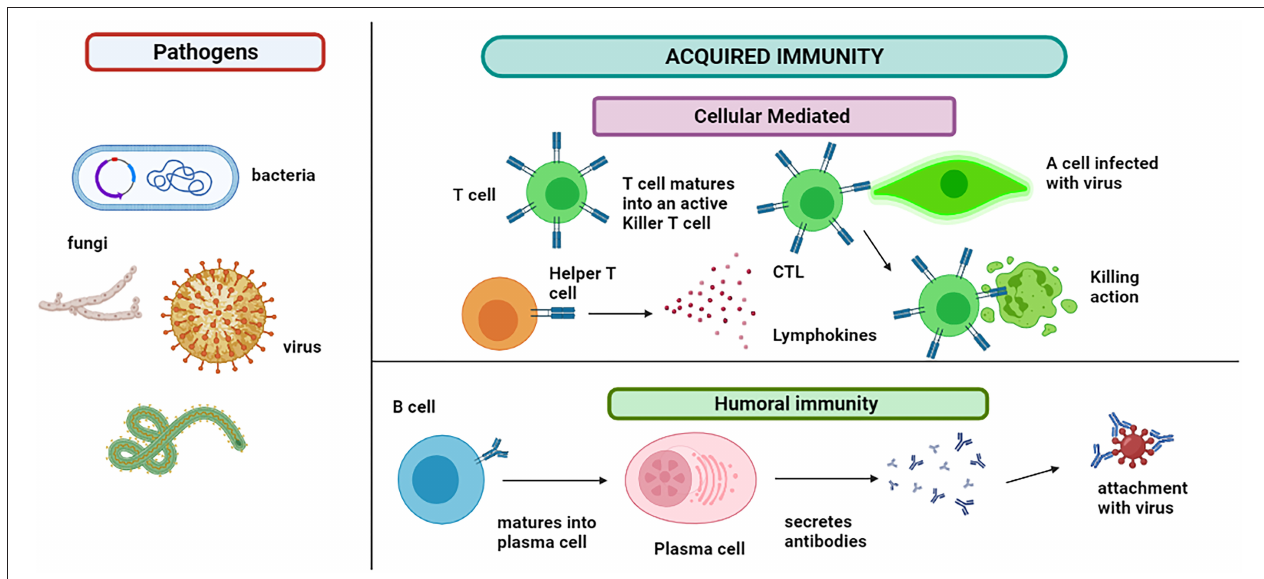
FIGURE 4 | Acquired immunity: immune cells show two types of responses. Humoral immunity involves the B cells that mature into plasma cells that secrete antibodies and attach to the pathogen. B cells also produce memory cells for the future attack of the same pathogen. Cytotoxic T lymphocytes (CTLs) are immune cells that play an important role in the fight against infections and tumor immunology. T cell matures into an active killer T cell called cytotoxic T lymphocytes, which attach to the infected cell and kill it. The lymphokines attract additional immune cells for stimulation and cascade the